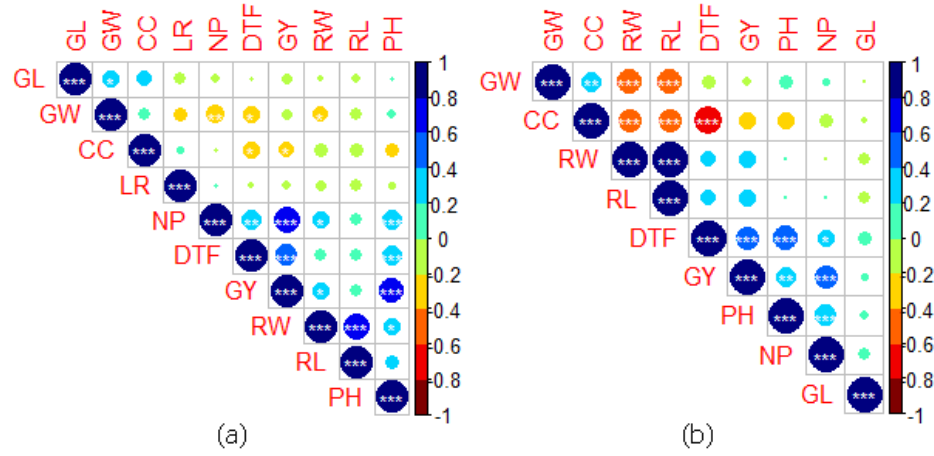
Figure 4. Correlation matrix of traits evaluated. ( a ) MRQ74 pyramided lines (PLs) under RS, ( b ) MRQ74 PLs under NS, Days to 50% flowering (DTF), plant height (PH) in cm, number of panicles (NP), chlorophyll content (CC), leaf rolling (LR), root weight (RW) in g, root length (RL) in cm, grain weight (GW) in g, grain length (GL) in cm, grain yield (GY) in kg ha − 1 . * p < 0.05, ** p < 0.01, ** p < 0.001.